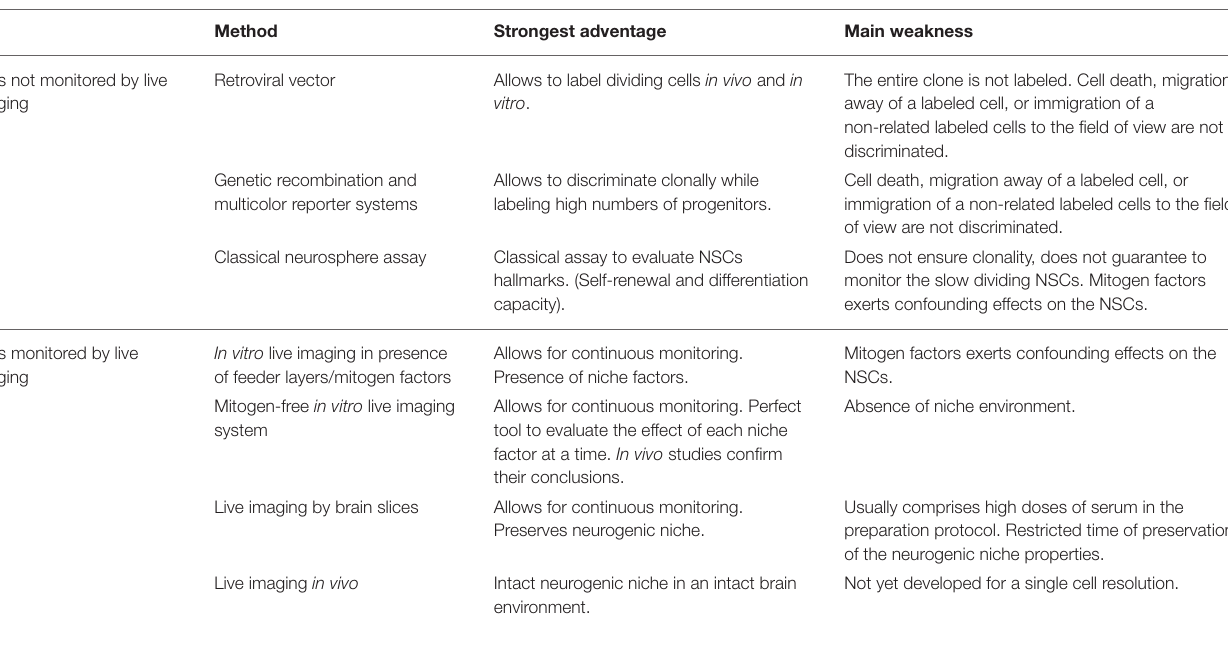
TABLE 1 | Different methods employed for lineage tracing of aNSCs, highlighting some of their strongest advantages, and main